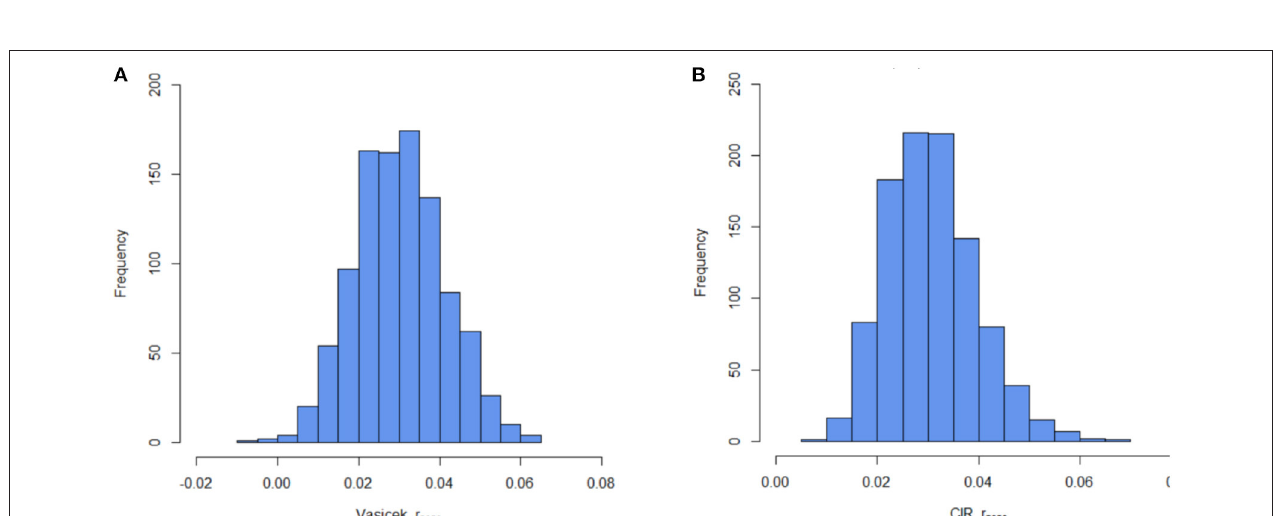
2050 based on the Vasicek model. (B) Simulation with the interest rate at t =